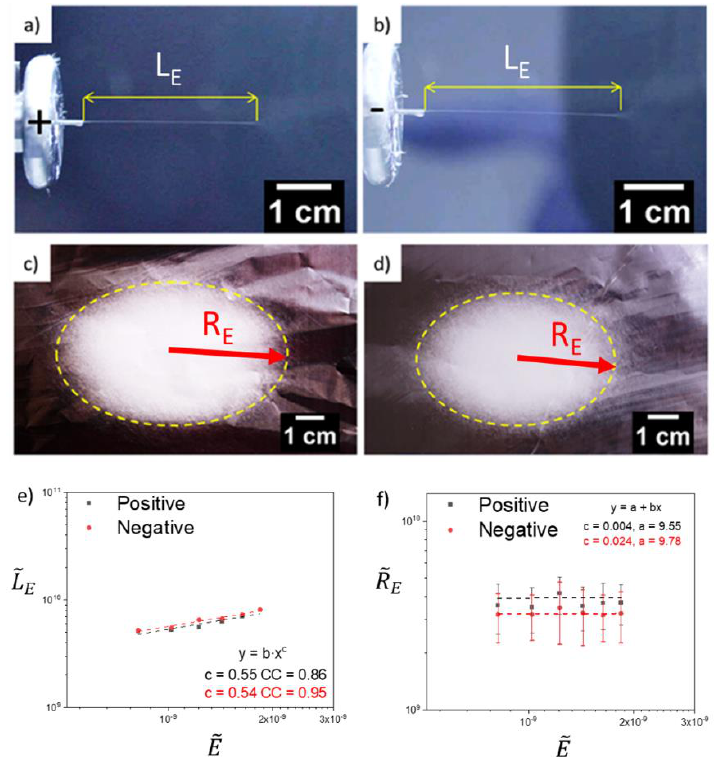
Figure 2. Images of the electrospinning polymer jet length before the bending instability begins and the area of deposited random fibers on Al foil for poly(methyl methacrylate) (PMMA) + ( a , c ) and PMMA- ( b , d ), respectively. ( e , f ) The dimensionless length, 𝐿̃ 𝐸 of the jet’s straight section and the dimensionless radius 𝑅̃ 𝐸 of the deposition area versus the dimensionless electrical field, 𝐸̃ on a log-log scale. cc- adjusted r-squared goodness-of-fit.